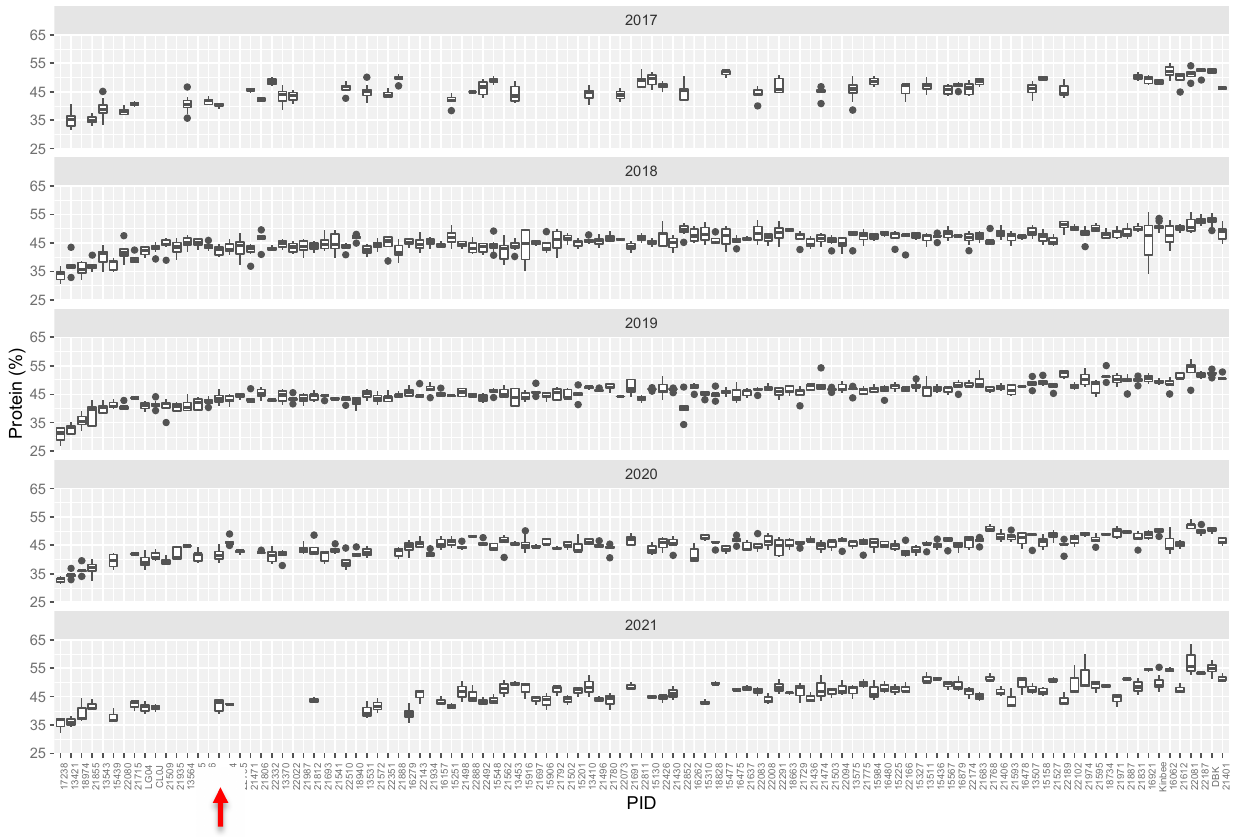
Figure 2. Tukey box plots of average seed protein content (%, dry weight basis). Seed protein content in M3 lines over five growing seasons. Lines are plotted left to right in order based on increasing median protein level over 5 years. Abbreviations: W82—Williams-82, LG04—LG04-6000, CL0J: CL0J-173-6-8, DBK: Danbaekkong. Red arrow indicates the Williams-82 (wild type) content.